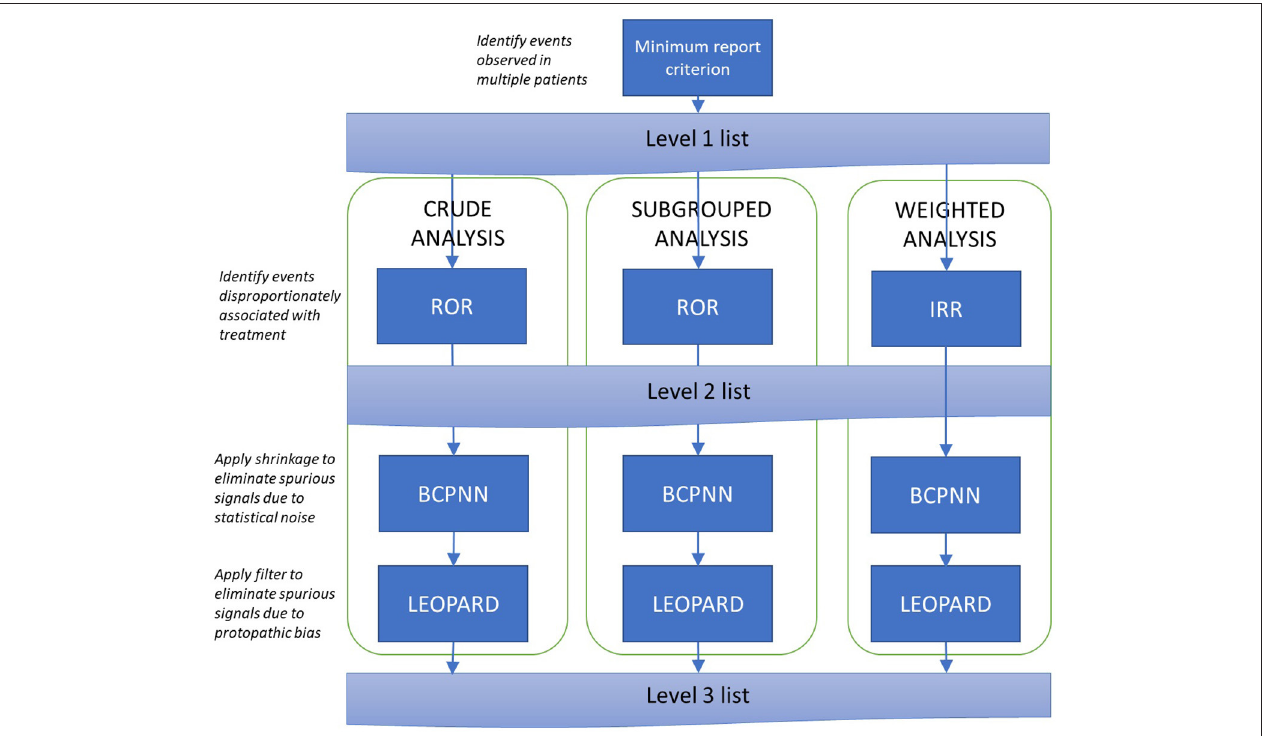
FIGURE 3 | Signal generation procedure. ROR, Reporting Odds Ratio; IRR, Incidence Rate Ratio; BCPNN, Bayesian Confidence Propagation Neural